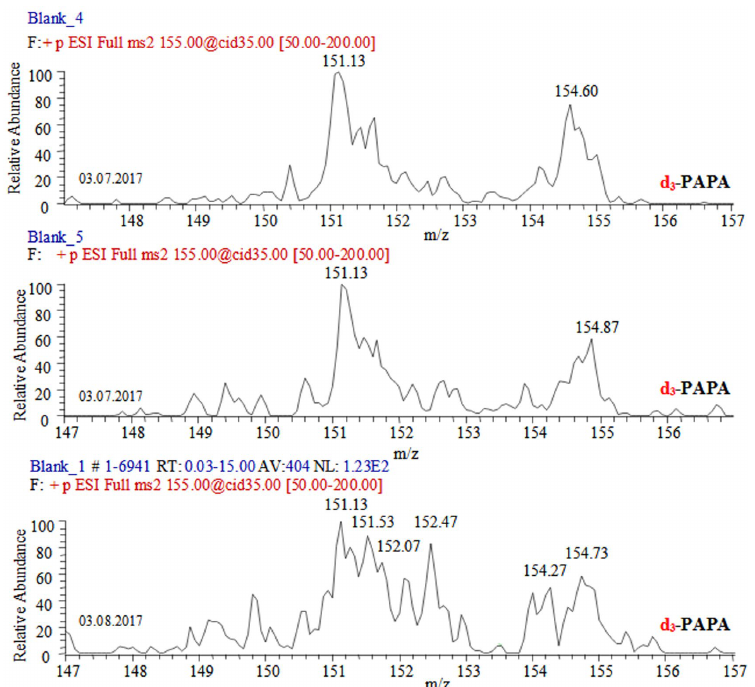
Figure 2. CID - MS/MS spectra of molecular cation [M+H] + of d 3 - deuterated paracetamol at m / z 155 Figure 2. CID-MS/MS spectra of molecular cation [M+H] + of d 3 -deuterated paracetamol at m / z 155 assessing within - day and between - day variability of mass spectrometric measurands. assessing within-day and between-day variability of mass spectrometric